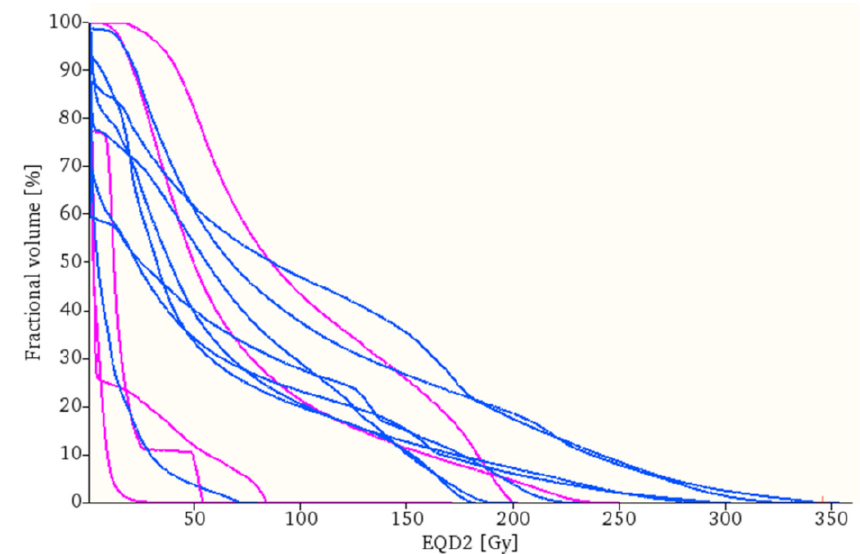
Figure 4. Dose–volume histograms (DVHs) for pneumonitis volume for SBRT + ICB (pink) and SBRT (blue). Doses are indicated in 2 Gy equivalent doses (EQD2). SBRT pneumonitis DVHs are shifted towards higher